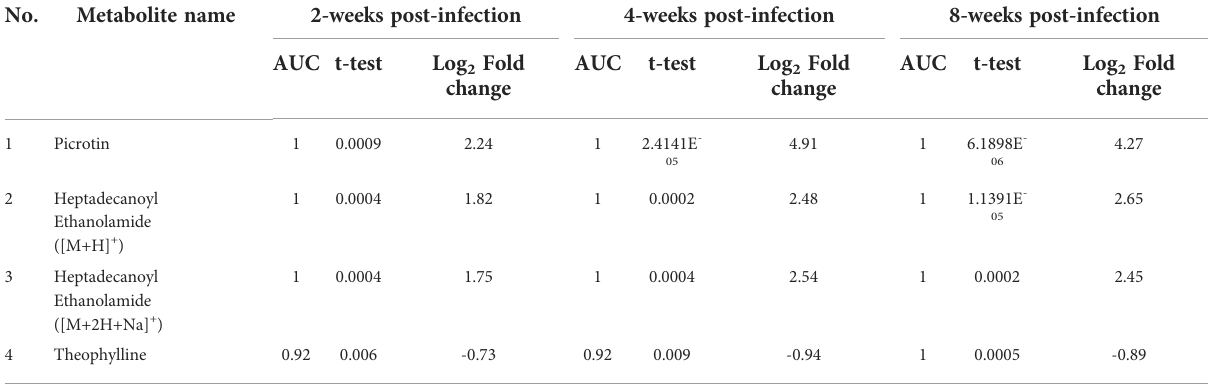
TABLE 2 Metabolites identi fi ed as signi fi cant in ROC curve analysis at all infection time-points. No.